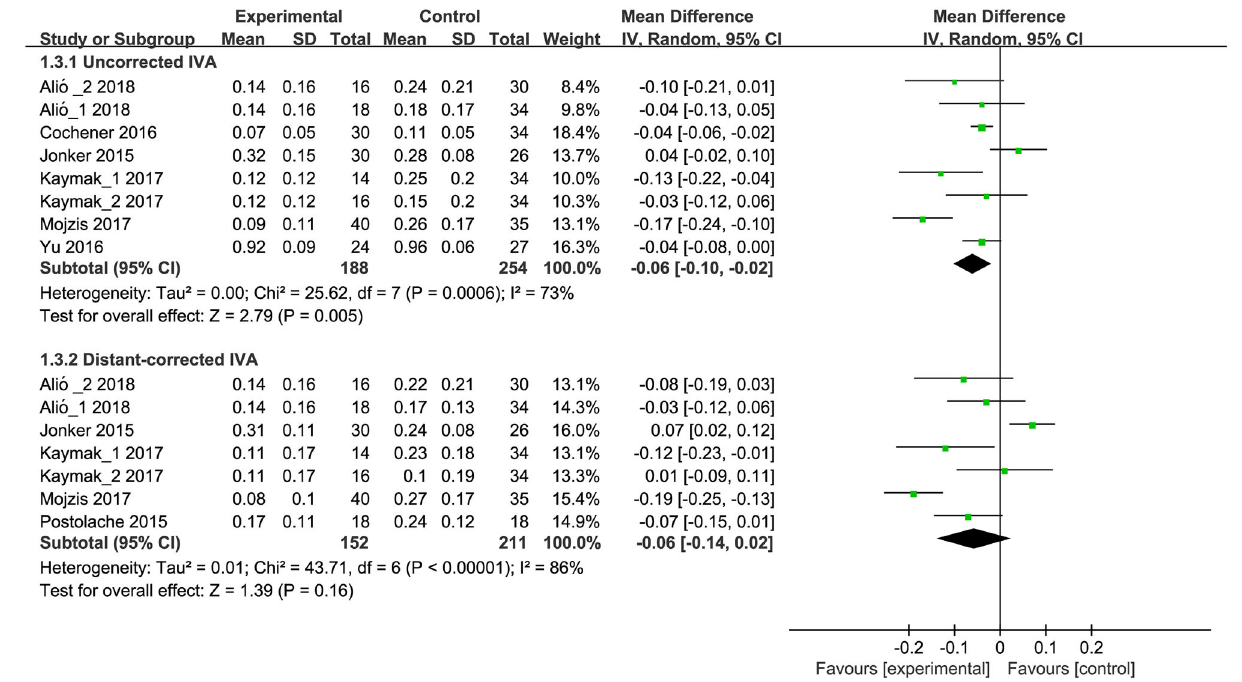
FIGURE 4 | Meta-analysis of IVA between trifocal and bifocal IOLs. SD, standard difference; IV, inverse variance; CI, confidence interval; IVA, intermediate visual acuity. Experimental and control indicate trifocal and bifocal IOLs, respectively.